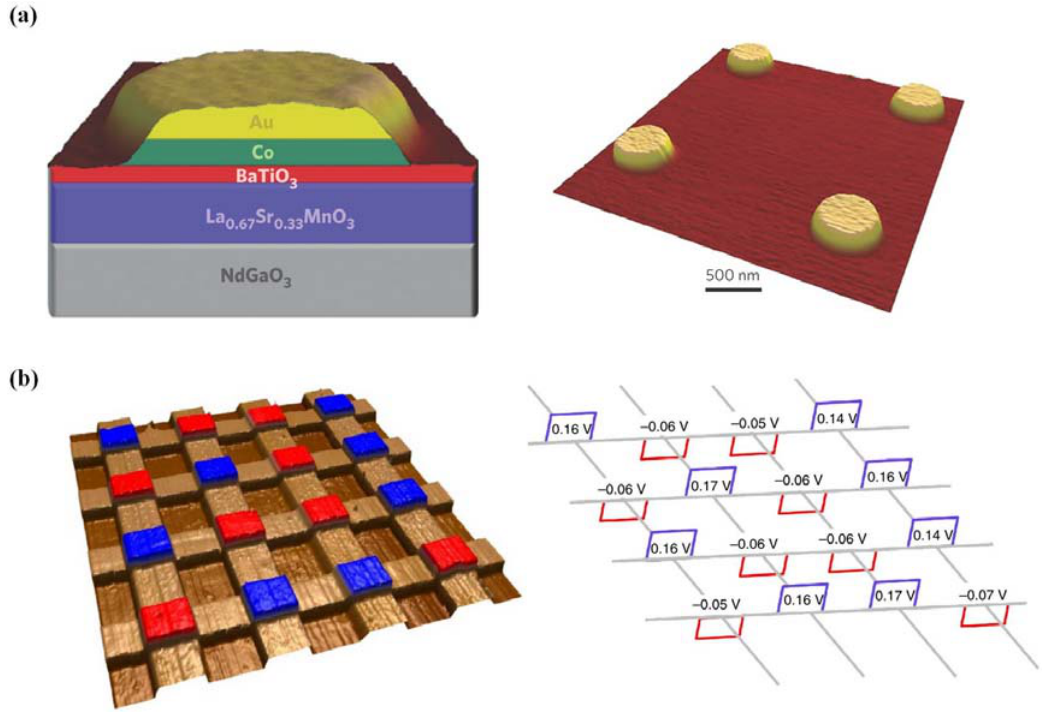
Figure 27. ( a ) Schematic of one gold/cobalt/BTO/LSMO nanodevice on a NGO substrate (left), and AFM image of four typical nanodevices defined using electron-beam lithography (right) [385]; ( b ) a prototype 16-cell memory based on the cross-bar architecture: topography of the device with preset polarization direction where blue ones refer to polarization up and red ones refer to polarization down (left), Voc of all 16 cells, measured under 20 mW·cm − 2 light (right) [578].